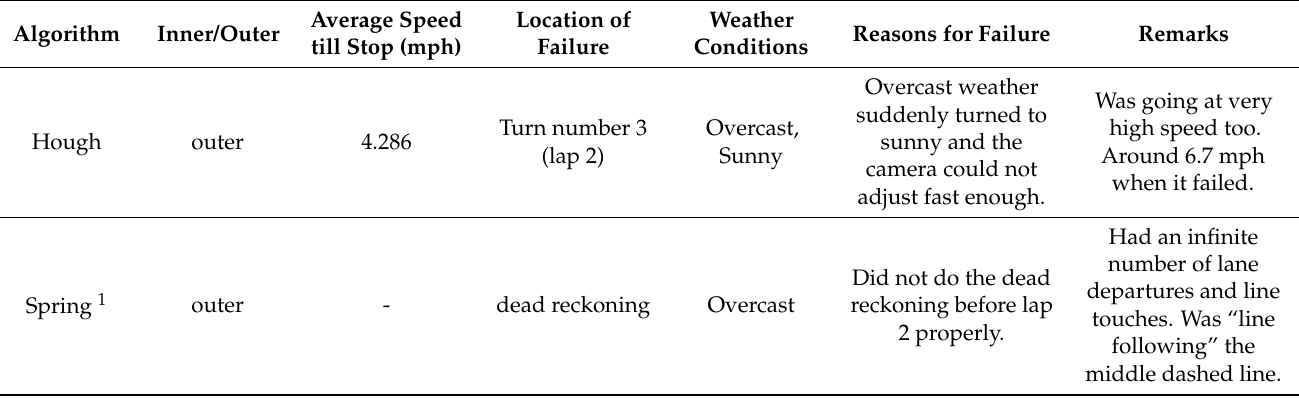
Table A2. Failure Cases on the official test